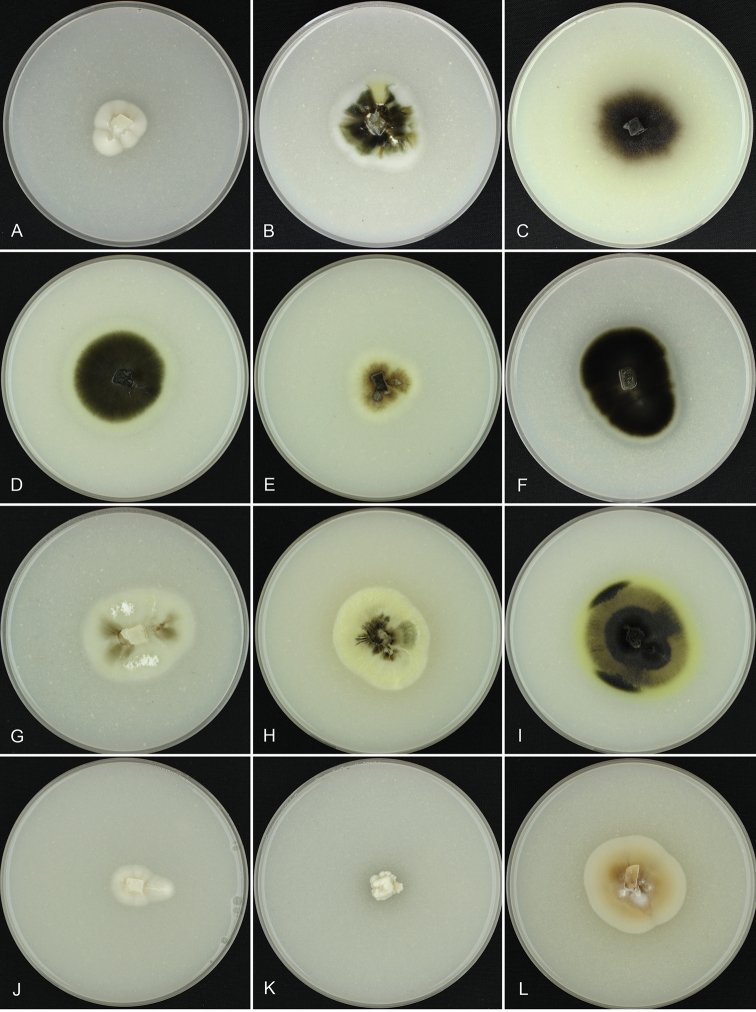
Colony surface of analysed strains on OA medium. AArboricolonus
simplexGLMC 459TBCadophora
africanaCBS 120890TCC.
bubakiiCBS 198.30TDC.
luteo-olivaceaGLMC 1264 EC.
novi-eboraciGLMC 1472 FC.
obscuraCBS 269.33 GC.
prunicolaCBS 120891THC.
prunicolaGLMC 1633 IC.
ramosaGLMC 377TJMinutiella
pruni-aviumGLMC 1624TKProliferodiscus
ingensGLMC 1751TLProliferodiscus sp. GLMC 460. Cultures A, J–L after 4 wk. Cultures B–I after 2 wk. Strains with a superscript T are ex-type cultures.